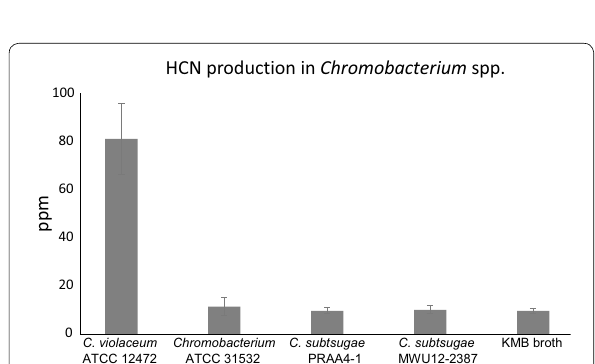
table fall below established criteria for species classification